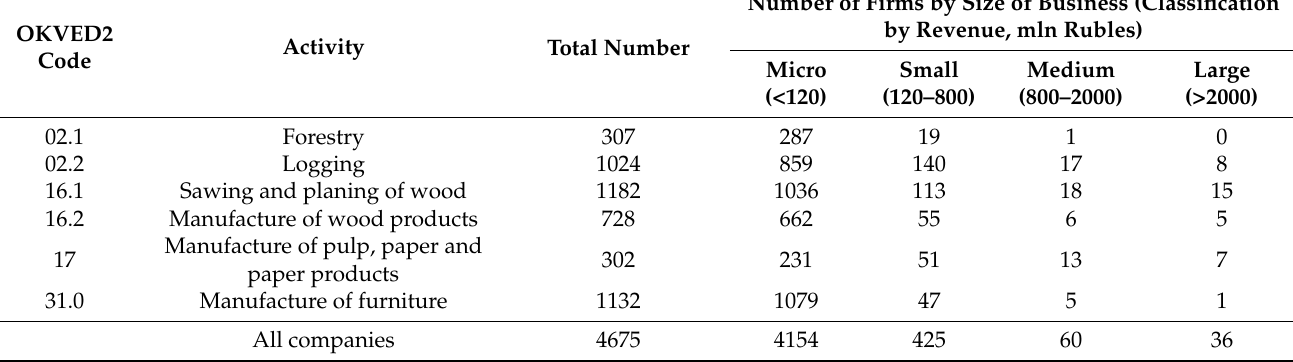
Table 4. Forest companies in Asian Russia by type of activity and revenue,